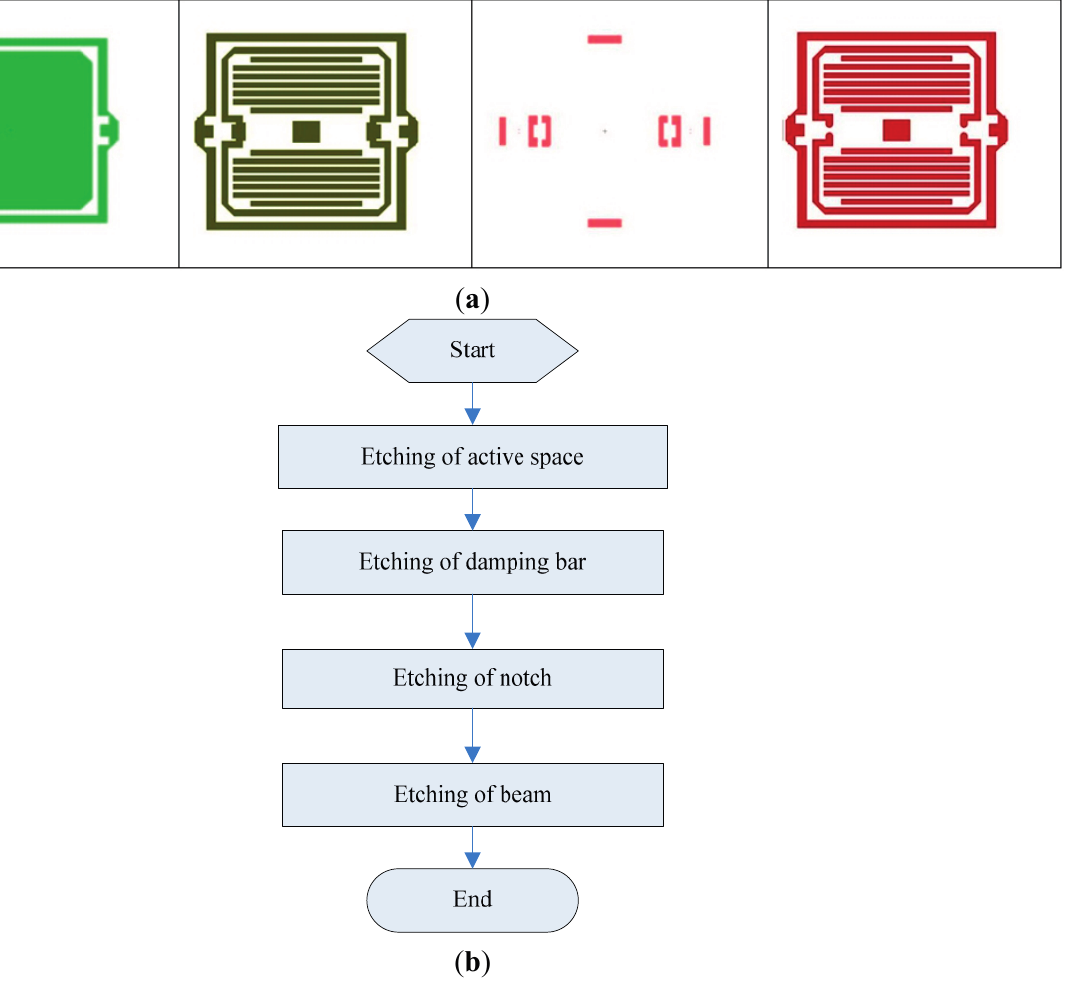
Figure 3. ( a ) The step of photo-mask; ( b ) The fabrication flow of the sensing element.